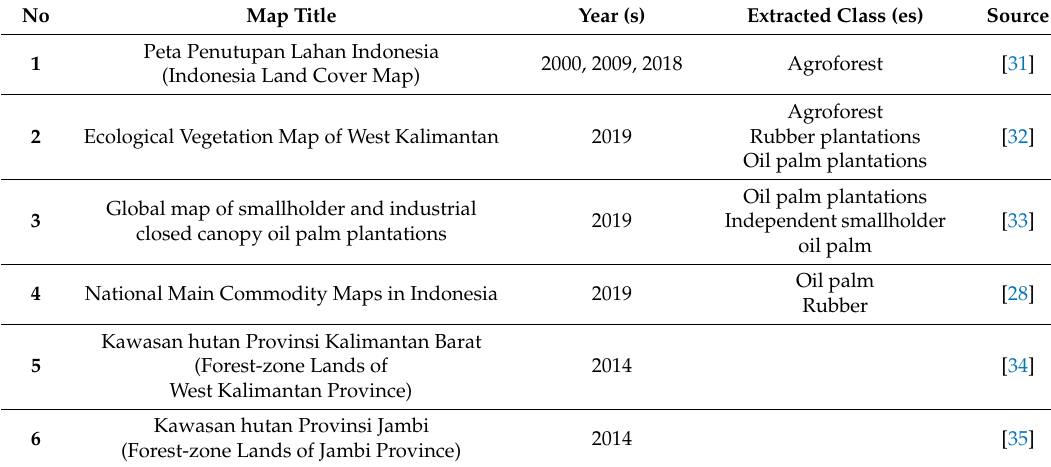
Table 1. Maps utilized for case